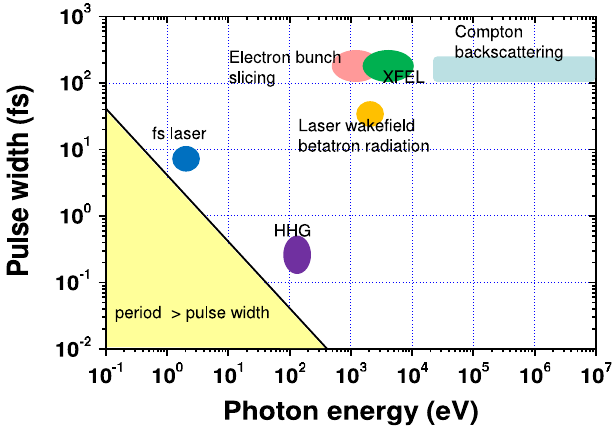
FIG. 1. Pulse duration and photon energy of currently avail- able ultrafast light sources: Compton backscattering [6], laser wakefield betatron radiation [10,11], electron bunch slicing [12–14], and XFEL [15–17]. No existing source produces ultra- fast ( < 80 fs ) with energies (cid:3) 10